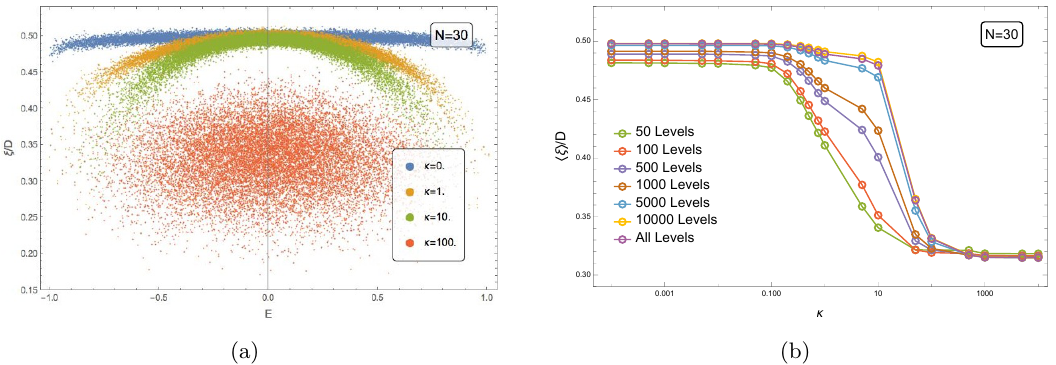
Figure 9 . Left: the distributions of the normalized IPR of the even parity sector ( D = 2 14 ) of N = 30 SYK model with (cid:20) = 0 ; 1 ; 10 and 100 versus normalized energy E , respectively. Right: the mean value of the normalized IPR of the subsectors of the spectra including L levels starting from the ground state of the even parity sector ( D = 2 14 ) of N = 30 SYK